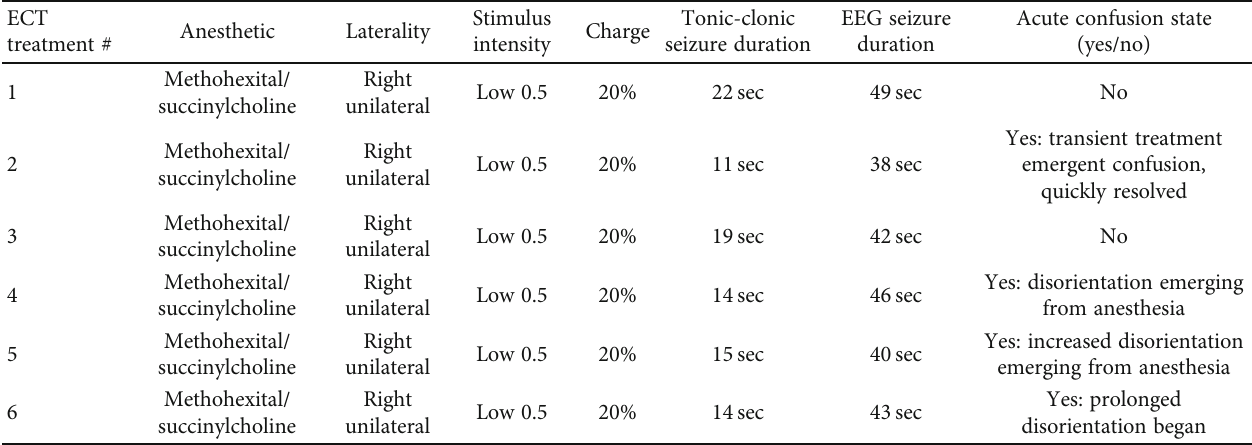
Table 1: Summary of ECT treatments and